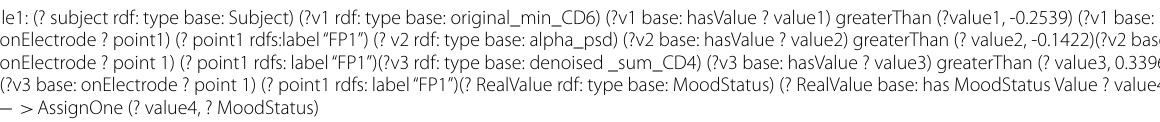
Table 4 An exemplary rule extracted from RF model rule1: (? subject rdf: type base: Subject) (?v1 rdf: type base: original_min_CD6) (?v1 base: hasValue ? value1) greaterThan (?value1, -0.2539) (?v1 base: onElectrode ? point1) (? point1 rdfs:label “FP1”) (? v2 rdf: type base: alpha_psd) (?v2 base: hasValue ? value2) greaterThan (? value2, -0.1422)(?v2